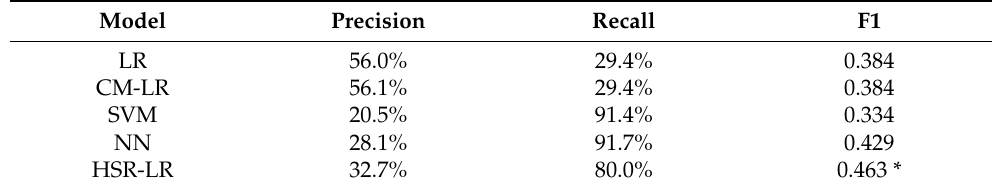
Table 10. Results on